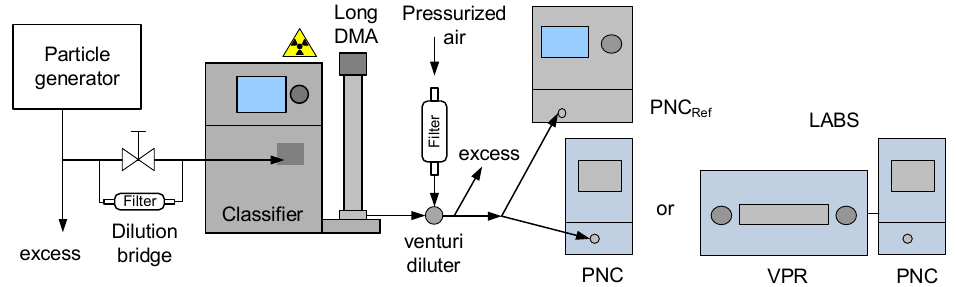
Figure 2. Experimental setup for monodisperse calibration of the PNC and complete LABS (VPR + PNC) system. DMA = differential mobility sizer; PNC = particle number counter; VPR = volatile particle remover.